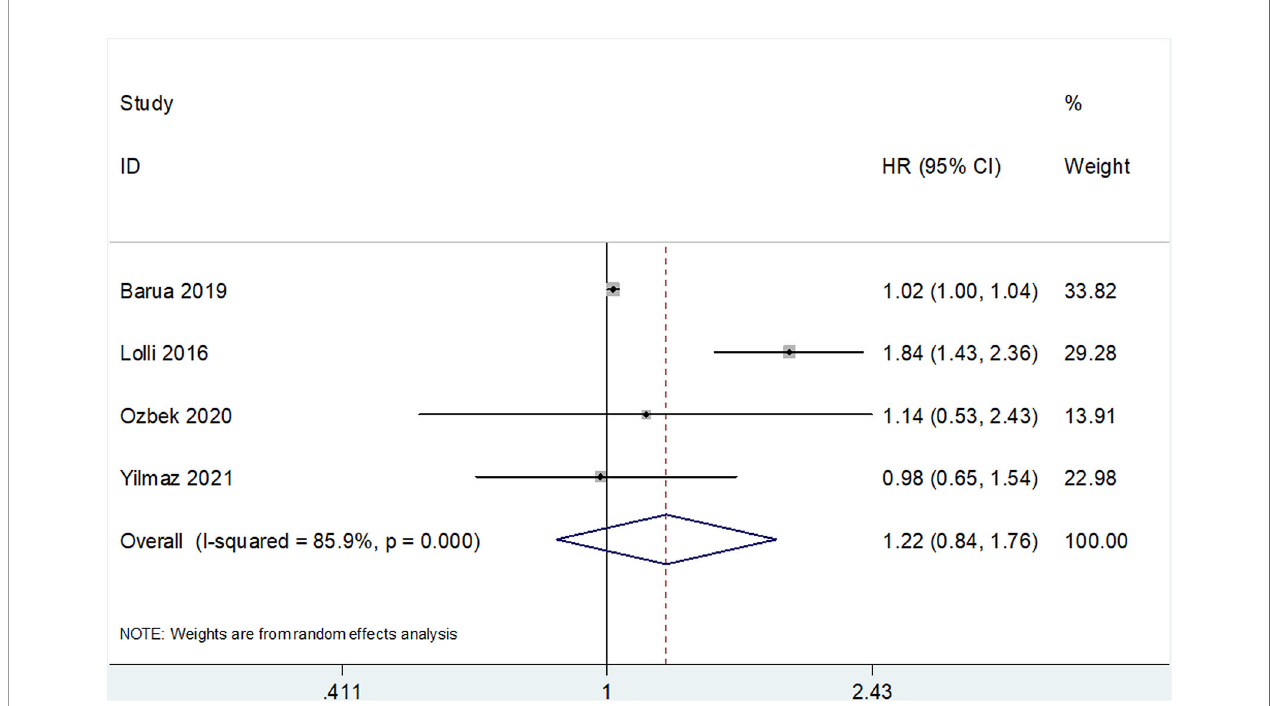
FIGURE 3 | Forest plots showing the association between SII and progression-free survival (PFS)/disease-free survival (DFS) in RCC.